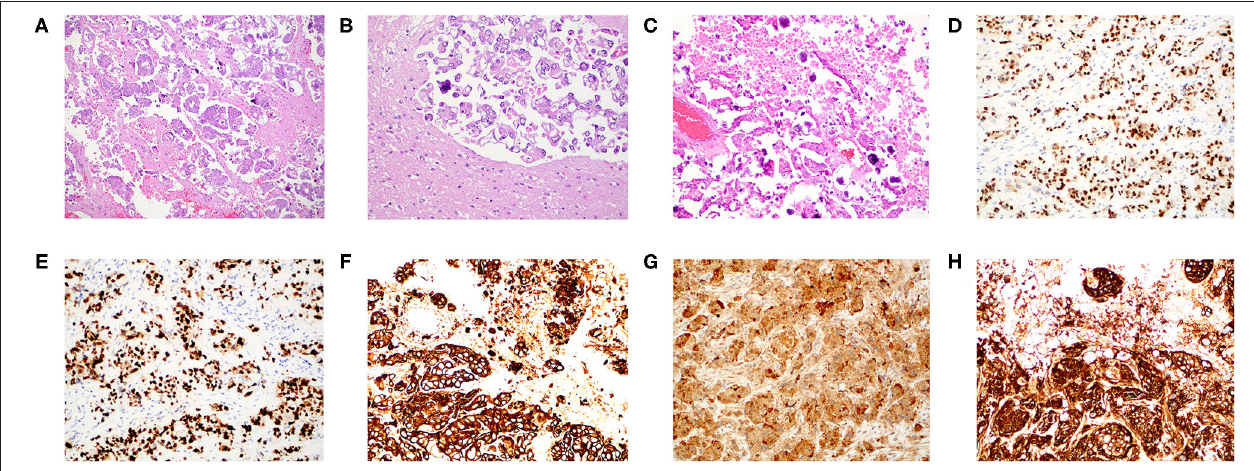
FIGURE 2 | Histopathology and immunohistochemistry of the intracranial metastatic serous carcinoma. (A) H&E stain at 100x magnification with nests and small papillae of pleomorphic tumor cells infiltrating brain parenchyma. (B) H&E stain at 200 × magnification demonstrating pleomorphic carcinoma with a well-formed psammoma body. (C) H&E stain at 200 × magnification demonstrating numerous psammoma bodies. (D) WT-1 immunostain at 200 × magnification demonstrating strong nuclear positivity. (E) p53 immunostain at 200 × magnification strongly marking the nuclei of all tumor cells. (F) Cytokeratin-7 immunostain at 200 × magnification with strong cytoplasmic reactivity. (G) p16 immunostain at 200 × magnification with strong nuclear positivity. (H) CA-125 immunostain at 200 × magnification with strong cytoplasmic